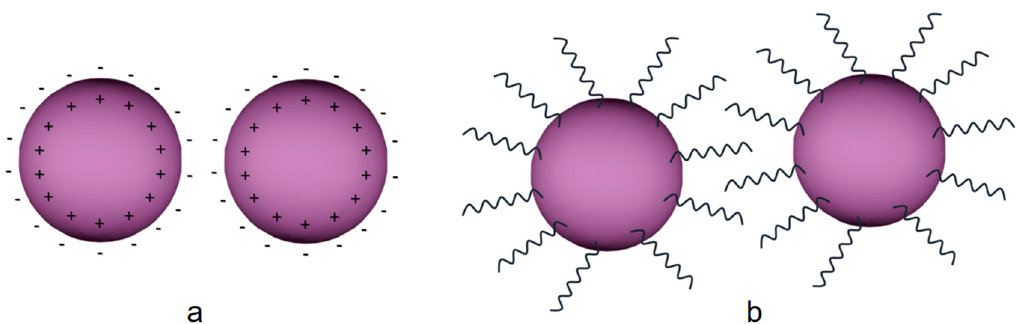
Figure 10. Schematic representations of ( a ) electrostatic stabilization and ( b ) steric stabilization in metallic nanoparticles.